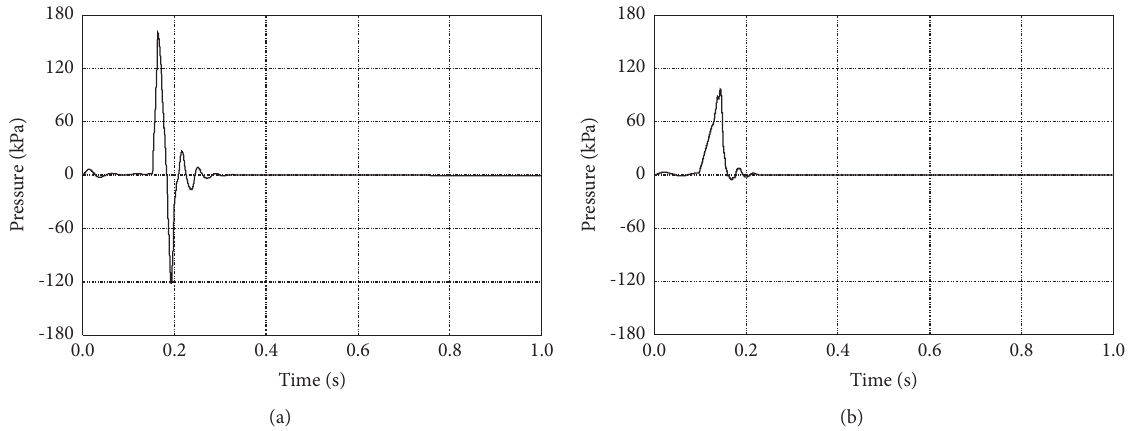
Figure 4: Pressure time history of the blast shock wave. (a) Scheme 1. (b) Scheme 2